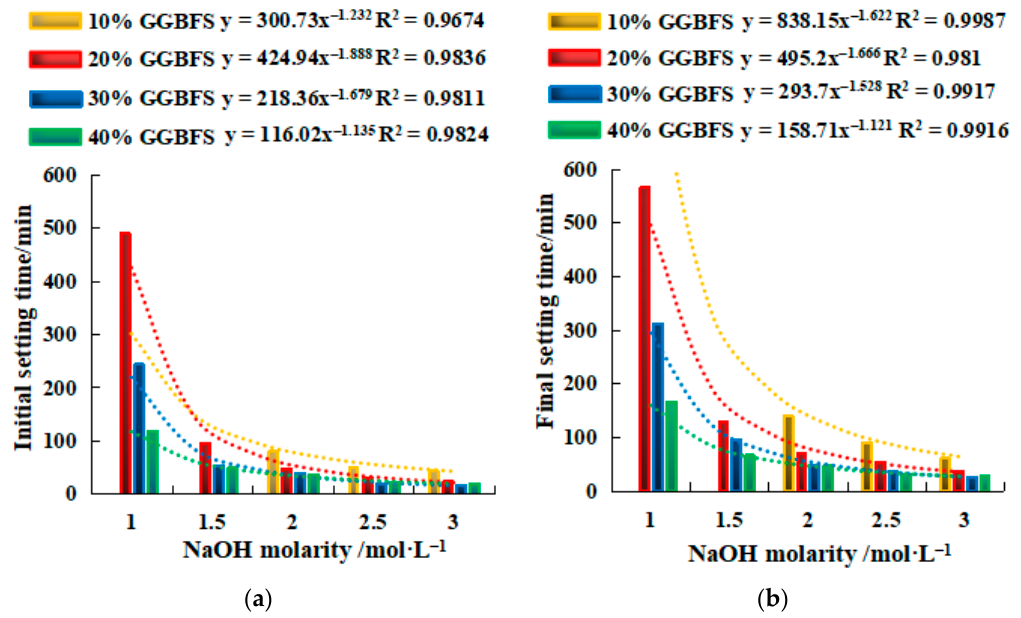
Figure 3. Relationship between NaOH molarity and setting time. ( a ) Initial setting time. ( b ) Final setting time. y = ax − b , where y is the setting time, min. x is the NaOH molarity, 1 ≤ x ≤ 3 mol/L. a and b are constants. The value of a is related to the GGBFS dosage, and a value decreases with the increase in GGBFS content. b is between 1 and 2.